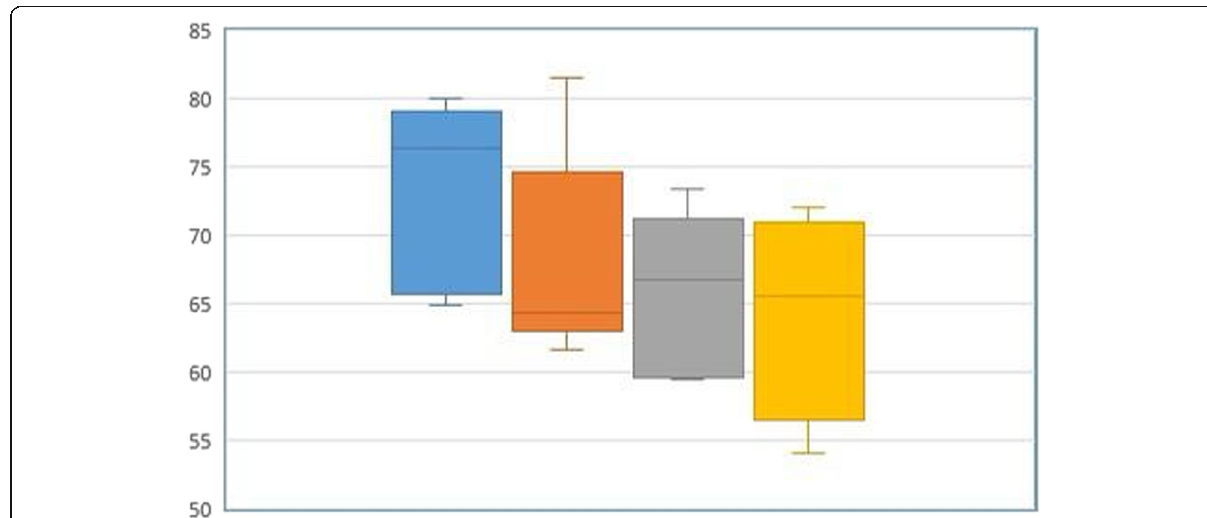
Fig. 3 The comparative assessment of the ISQ values in type IV bone (SP [n 9], BLT [n 10], TE [n 7], and BLX [n 8]) in both groups (regardless of the presence of cortical bone) revealed that the BLX design had significantly higher mechanical anchorage compared to other implant